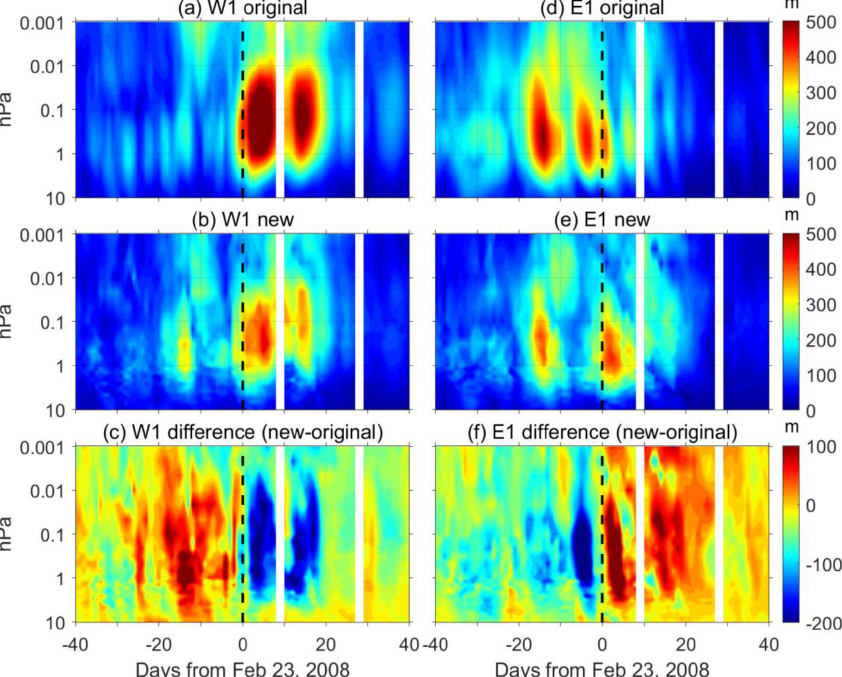
Figure 4. The amplitudes of the W1 (a, b, c) and E1 (d, e, f) Q5DOs during the 2008 SSW obtained by the original least squares fitting method (a, d) and the new fitting method (b, e) . The differences between the new and original methods are shown in panels (c) and (f) . Contour steps are 10m.